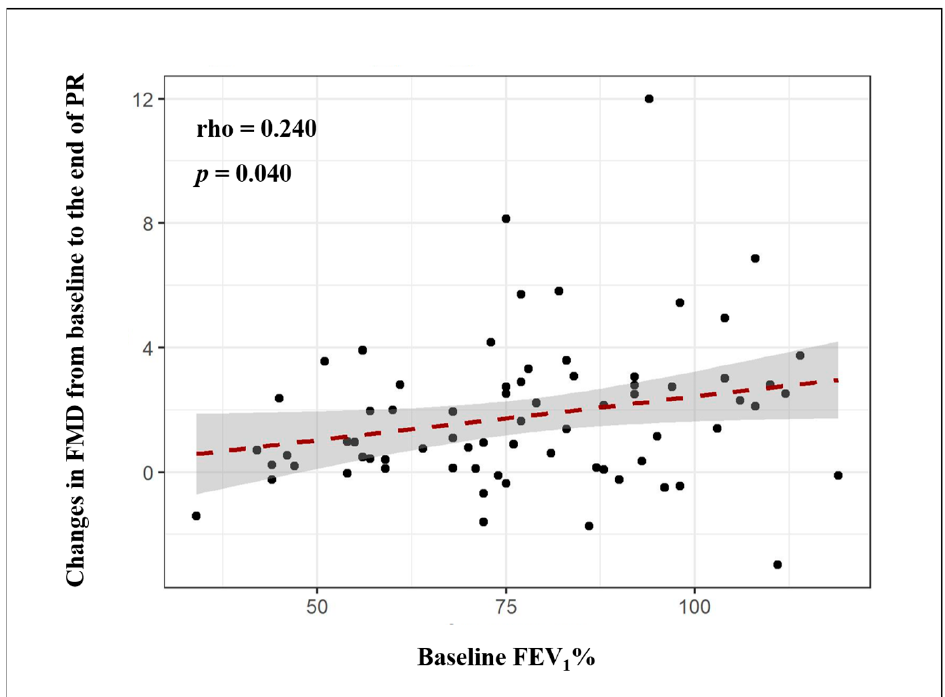
Figure 2. Relationship between changes in flow-mediated dilation (FMD) after pulmonary rehabilitation and baseline values of forced expiratory volume in 1 s (FEV 1 ).